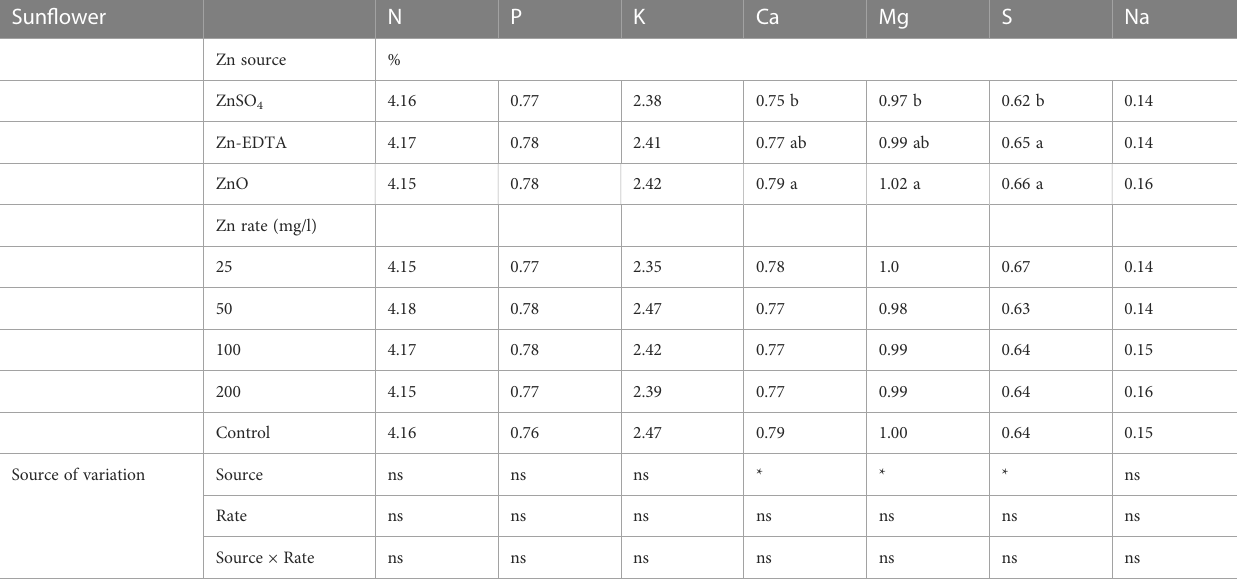
Sun fl ower N P K Ca